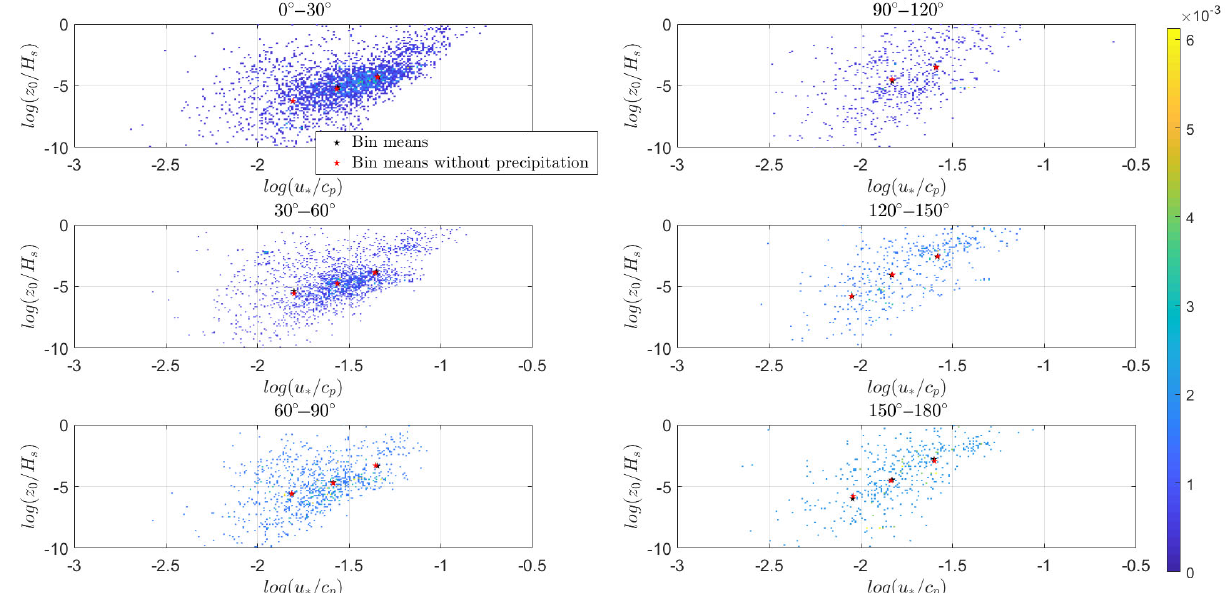
Figure B1. The dimensionless roughness length is plotted against the inverse wave age parameter for six different groups of align- ment. In each figure the data are bin averaged, with the bin means (logarithmic) indicated by black stars. The bin means of the mea- surement data excluding the precipitation measurements are indi- cated by red stars. The color scale to the right indicates the proba- bility of occurrence (%) of the measurement